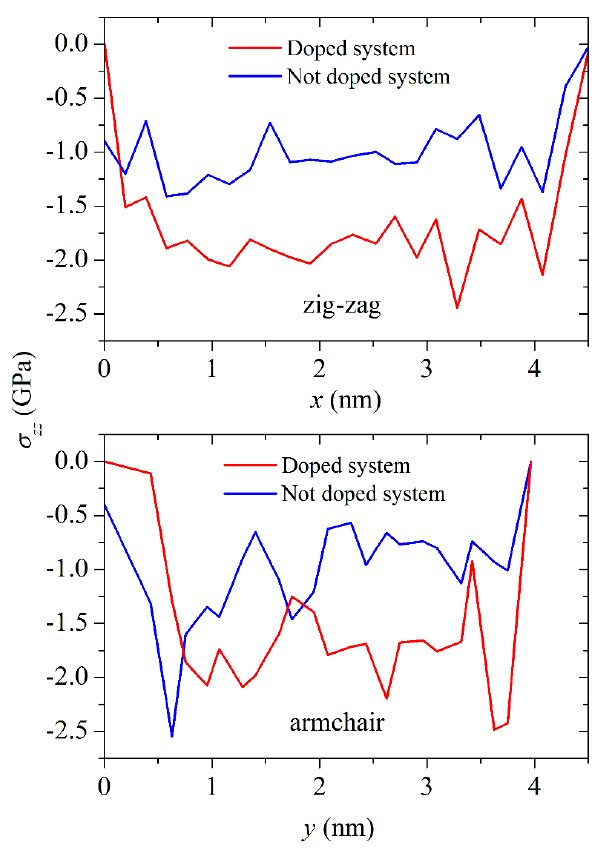
Figure 6. Distribution of σ zz stresses in the zigzag (top) and armchair (bottom) directions for the systems (“silicene channel–carbon substrate”) not subjected to and subjected to NTD when the channel was completely filled with lithium. The channel width was 0.24 nm.